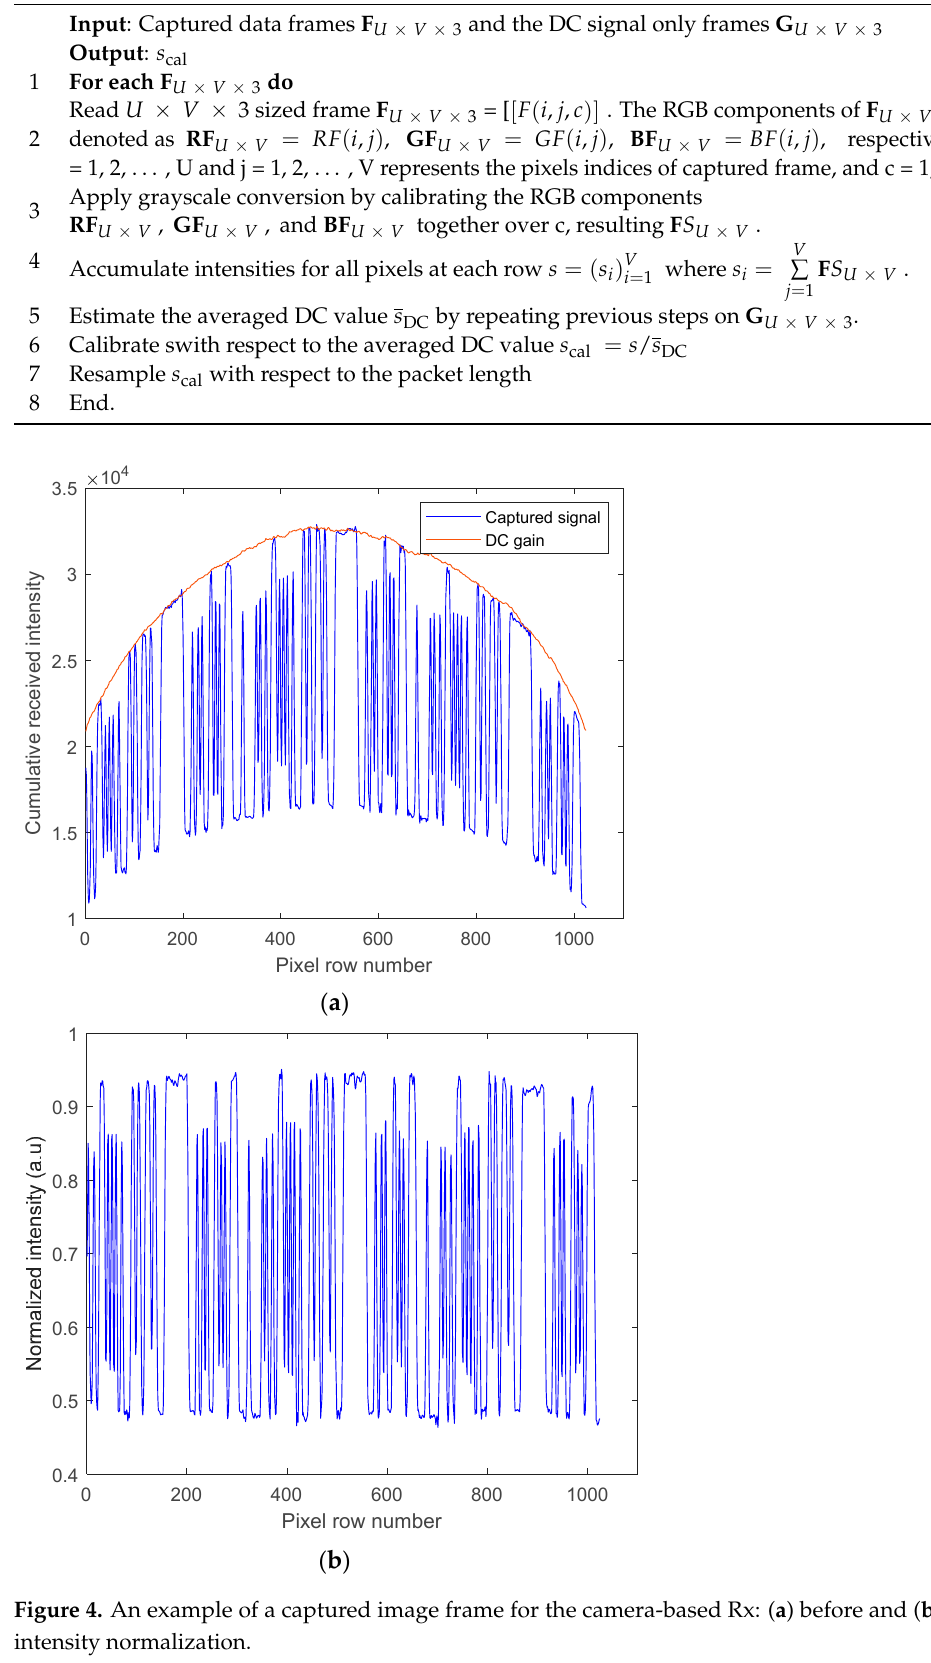
Algorithm 1. The image processing algorithm for signal extraction.